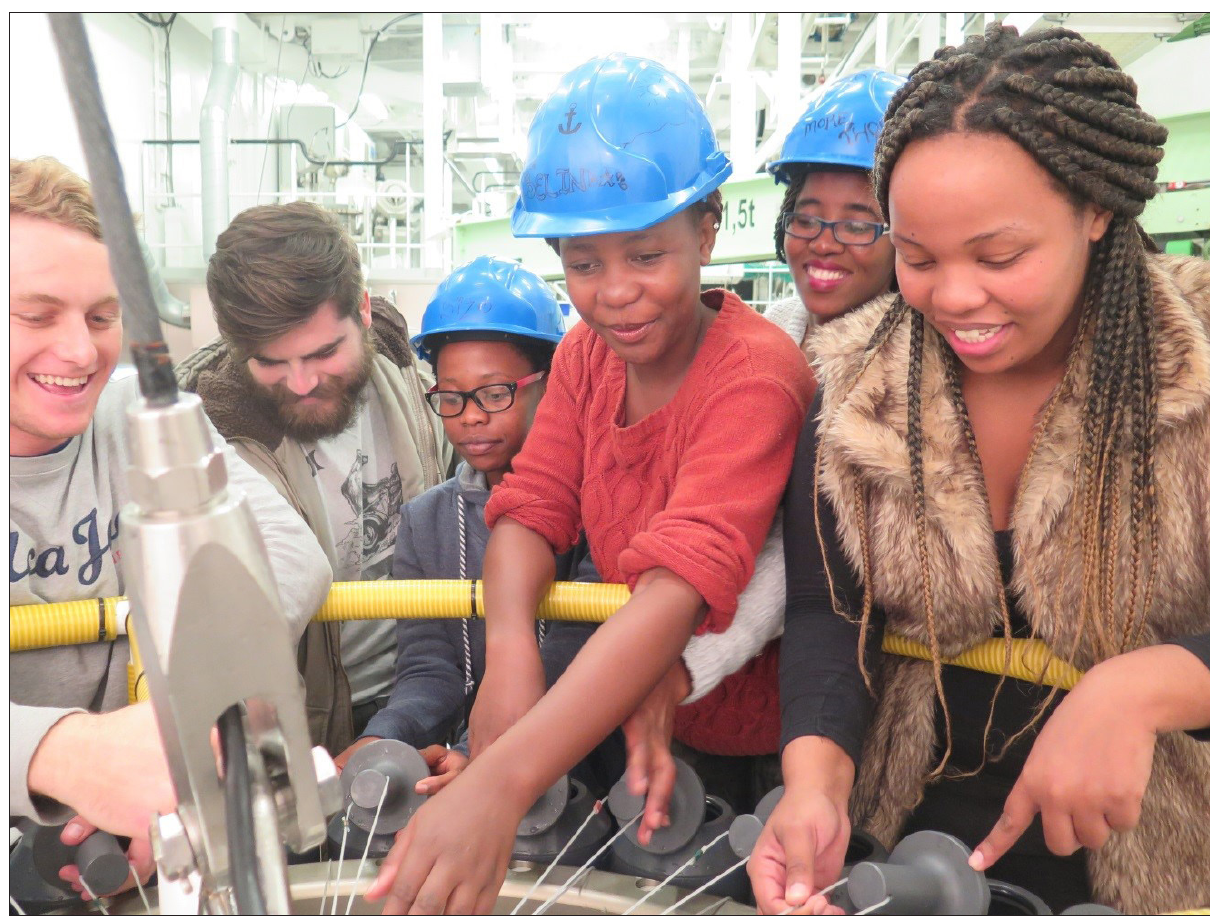
Figure 3: SEAmester students getting the CTD (conductivity, temperature and depth) device ready for water sample collection at the next station. From left to right: Stephen Peel (UCT), Hermann Luyt (SUN), Sizakele Sibanda (UCT), Belinda Nhesvure (UFH), Thoko More (TUT) and Ntombi Nxiba